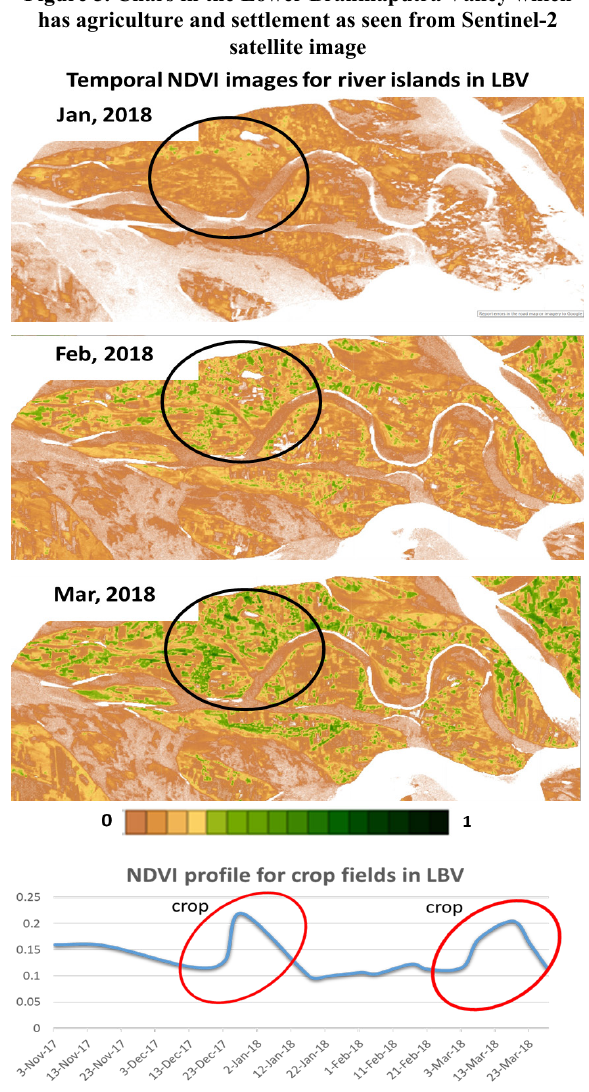
Figure 6. Change in NDVI profile for the non-monsoon season depicting the cropping intensity within the chars in LBV as seen from Sentinel-2